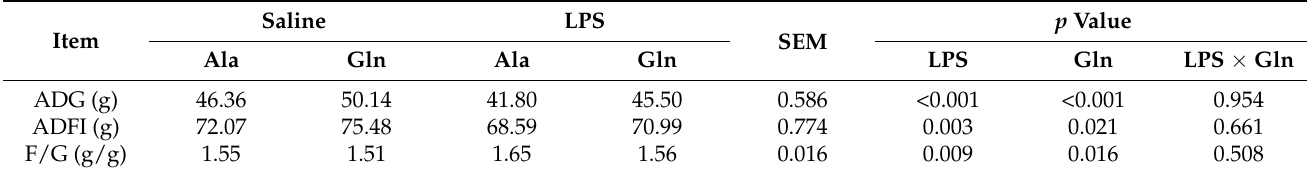
Table 3. Effects of dietary Gln supplementation on growth performance of broilers challenged with LPS.